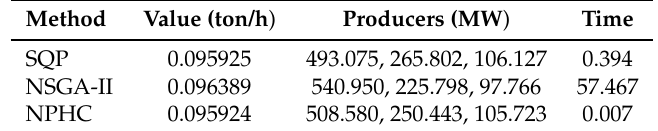
Table 3. Minimization of NO x emissions.